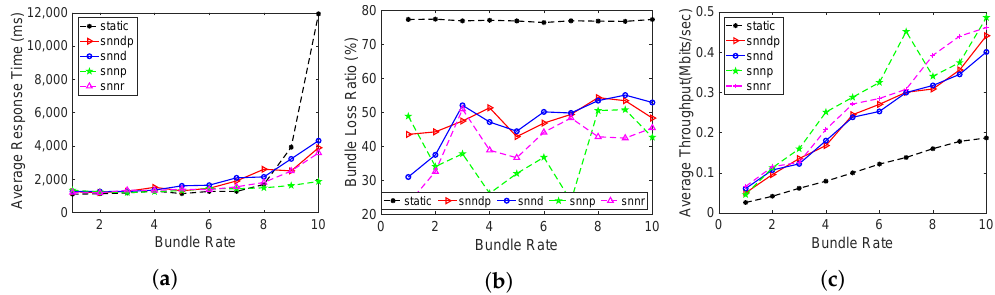
Figure 15. Routing performance: Scenario 7. ( a ) Average response time; ( b ) Packet loss ratio (%); ( c ) Throughput.